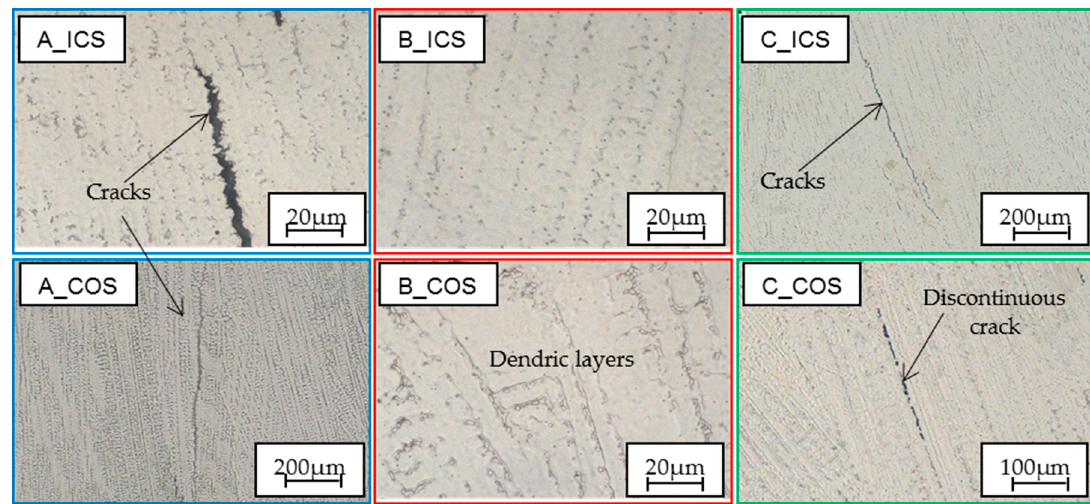
Figure 10. Micrograph of dendritic structure for the ICS and COS samples .